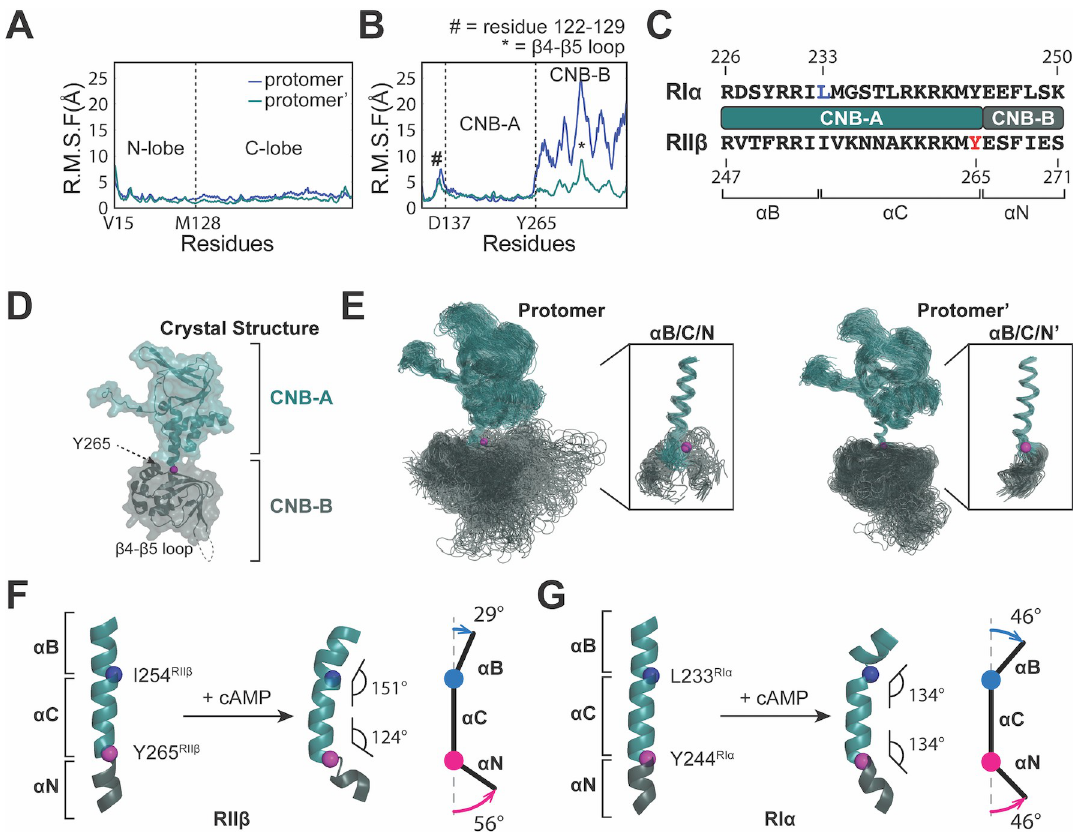
Fig 2. MD simulations of the RII β 2 C 2 holoenzyme reveal functional and isoform-specific dynamics. ( A ) Both N- and C-lobe of the C subunit remain stable in the RMSF analysis of RII β 2 C 2 holoenzyme. ( B ) CNB-B domain of the RII β subunit in one of the protomers is flexible in the RMSF analysis in RII β 2 C 2 holoenzyme. ( C ) Domain diagram and residues of the B/C/N-helix in RI α and RII β subunit. ( D ) RII β subunit in the RII β 2 C 2 holoenzyme crystal structure (PDB ID = 3TNP). ( E ) The overlaid of all states of each RII β subunit protomer in the RII β 2 C 2 holoenzyme from MD simulations. CNB domain in one of the protomers is more flexible than the other, and both of the protomers have breakages at Tyr265. Residue Tyr265 RII β was shown as pink ball. ( F , G )The conformational change of RII β (F) and RI α (G) B/C/N-helices upon cAMP stimulation. The main pivot point of RII β B/C/N-helix is at Tyr265 RII β (G), while the main pivot point of RI α B/C/N-helix is at Leu233 RI α (G). The data used to make these figures can be found in S1 Data. CNB, cyclic nucleotide binding; MD, molecular dynamics; PDB, Protein Data Bank; RMSF, root-mean-square fluctuation.